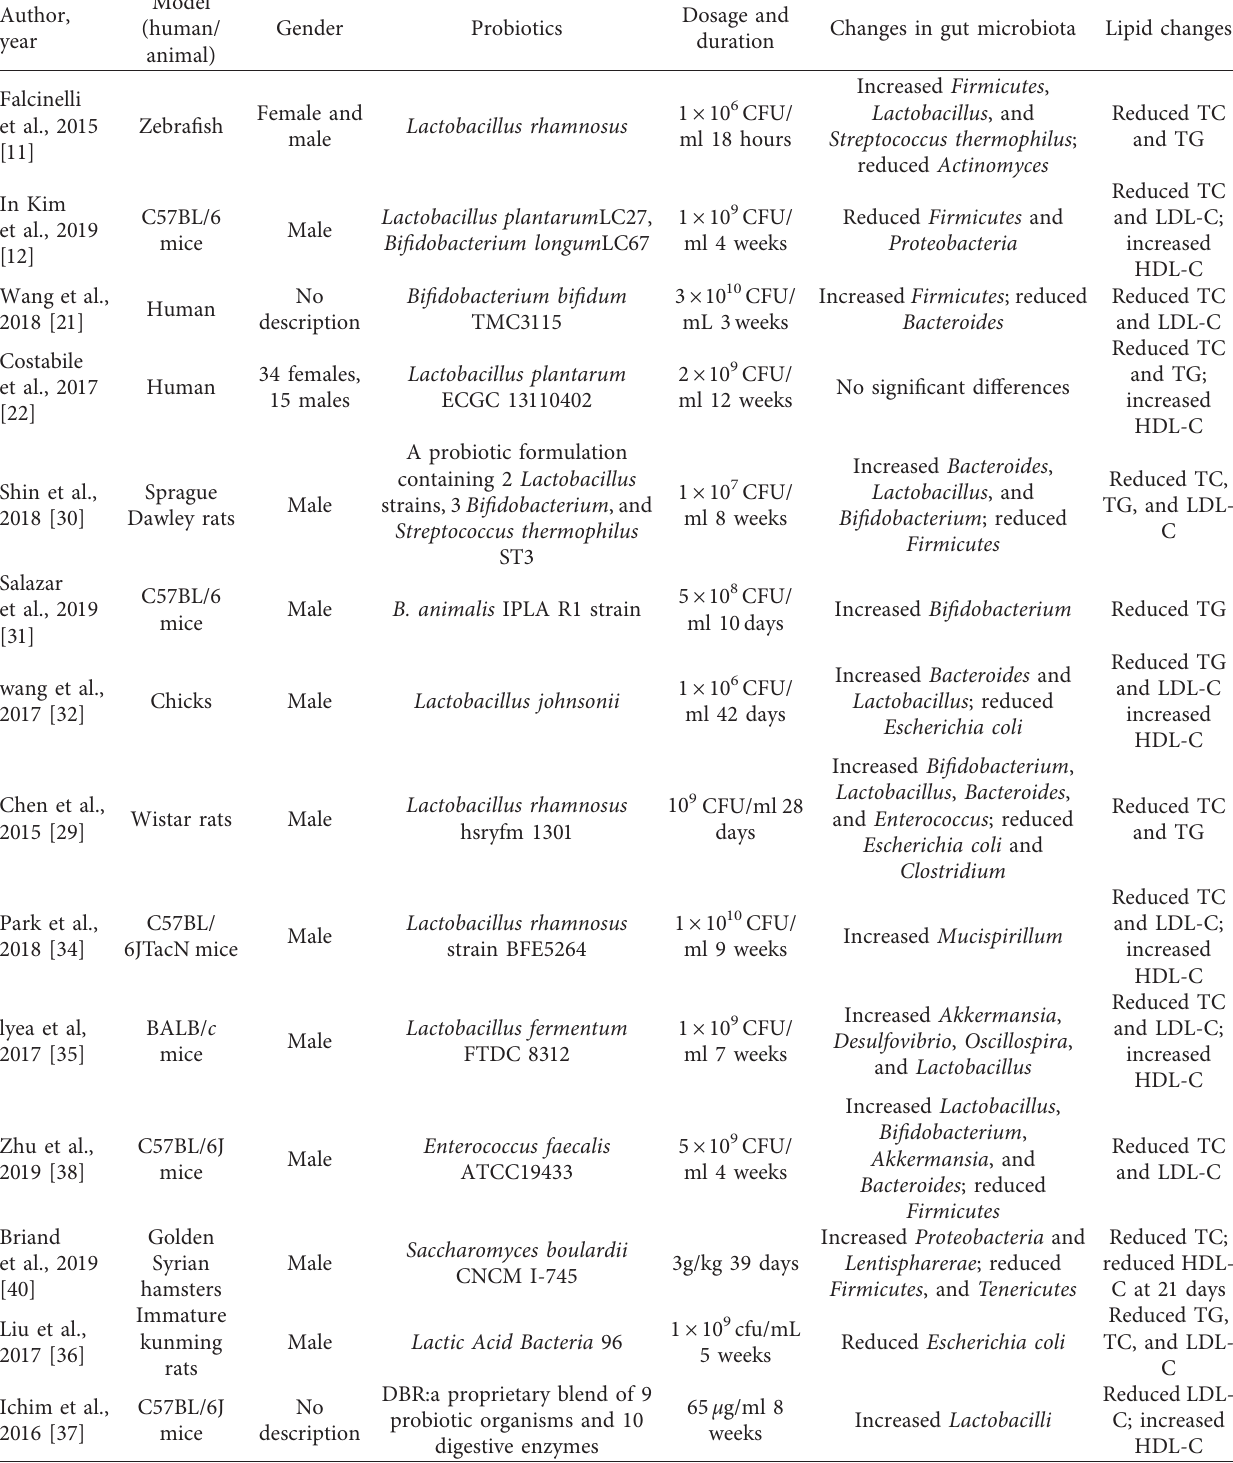
Table 1: Recent studies on the effects of probiotics on